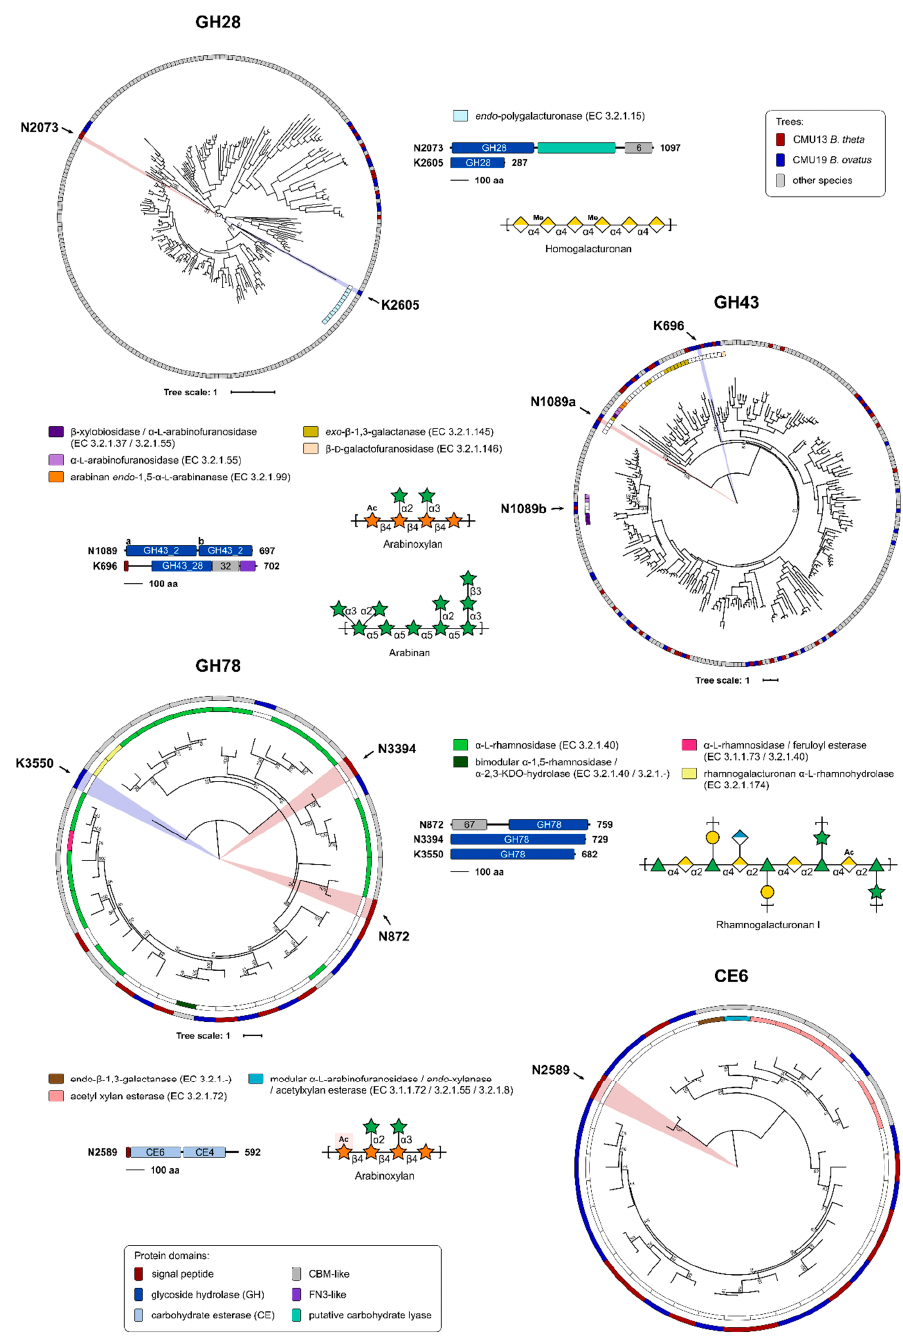
Figure 6. Prediction of enzyme activities and target selection by phylogenetic analyses. Genomes from isolates CM13 ( B. theta ) (red) and CM19 ( B. ovatus ) (blue) were annotated by Prokka [46]. Putative protein sequences were annotated by dbCAN [54] and used as query sequence inputs for SACCHARIS [48] and embedded into phylogenetic trees of characterized GH28, GH43, GH78, and CE6 enzymes. EC number and CAZy database annotated functions are colour-coded as indicated. Target enzymes were chosen based on distally related sequences, represented by novel clades within the phylogenetic trees. Domain boundaries are based on manual curation of predictions by dbCAN [54] and InterProScan [55], with all schematics to scale and colour-coded. The polypeptide length for the open reading frame of each target is shown. Schematics of potential plant cell wall substrates for selected target CAZymes, as identified by EC number, are